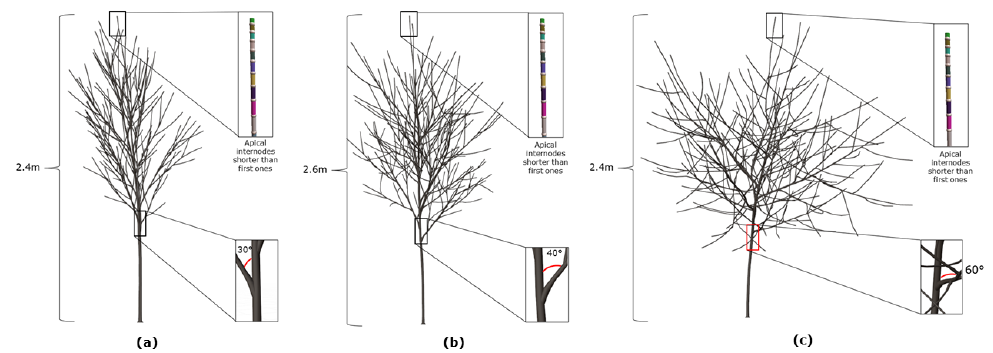
Figure 10. Tree growth with fixed temperature (25 °C), fixed light source (top) and amount and 2 children branches. The branching angle showed is ( a ) 30°, ( b ) 40° and ( c ) 60°. The apical internodes are displayed with different colors for showing